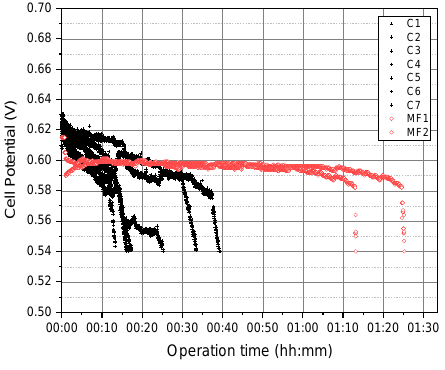
Figure 9. Voltage variations of each purge cycle (C1 – C7, channel; MF1 – MF2, metal foam).